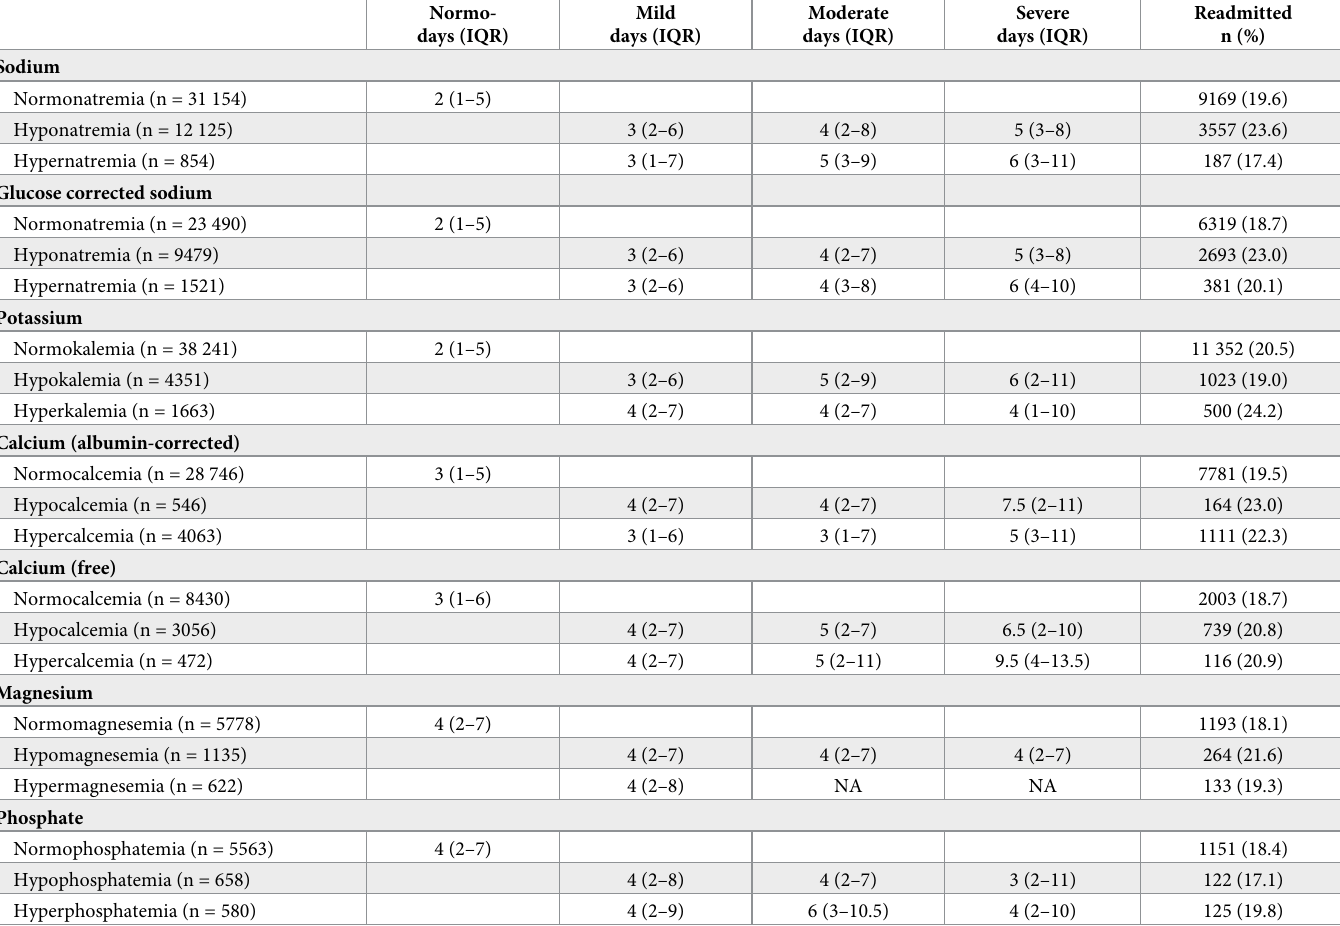
Table 3. Median length of hospital stay by degree of severity of the electrolyte imbalance and number of readmissions within 30 days after discharge for all admis- sions 2010–2015.